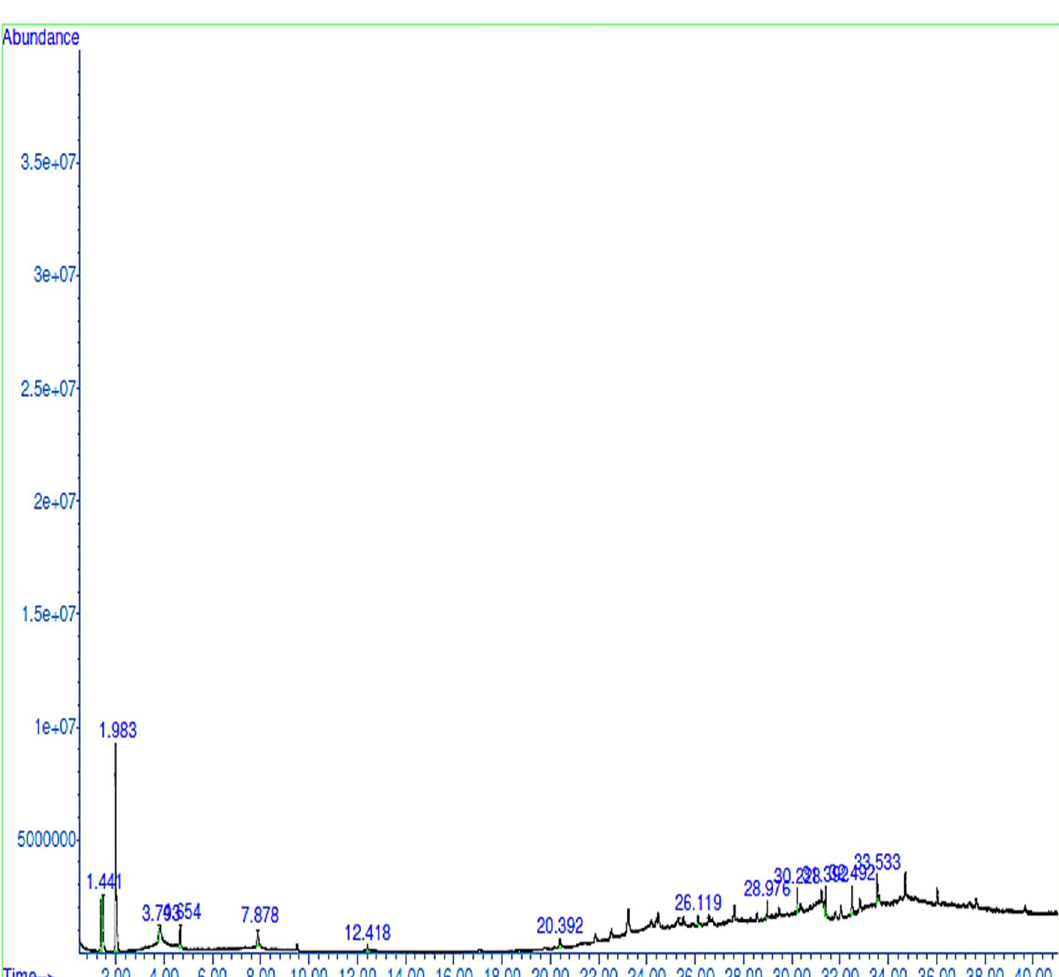
Figure 1. GC–MS Chromatogram of X. aethiopica